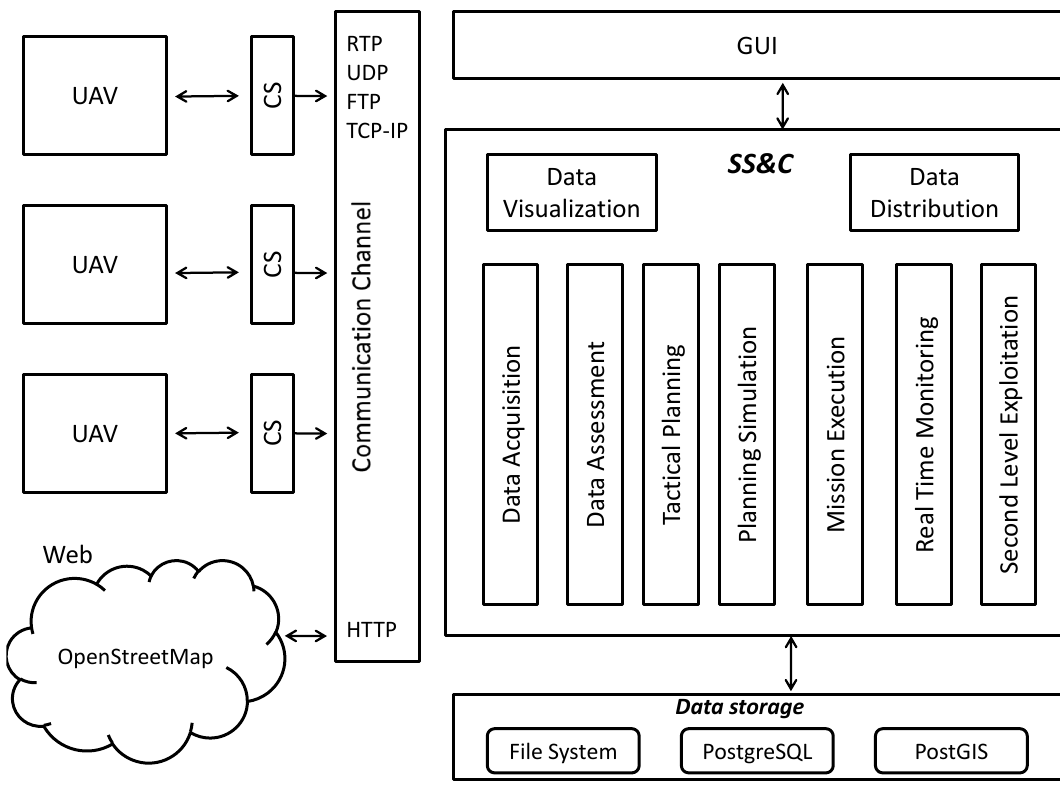
Figure 2. SMAT-F1 software